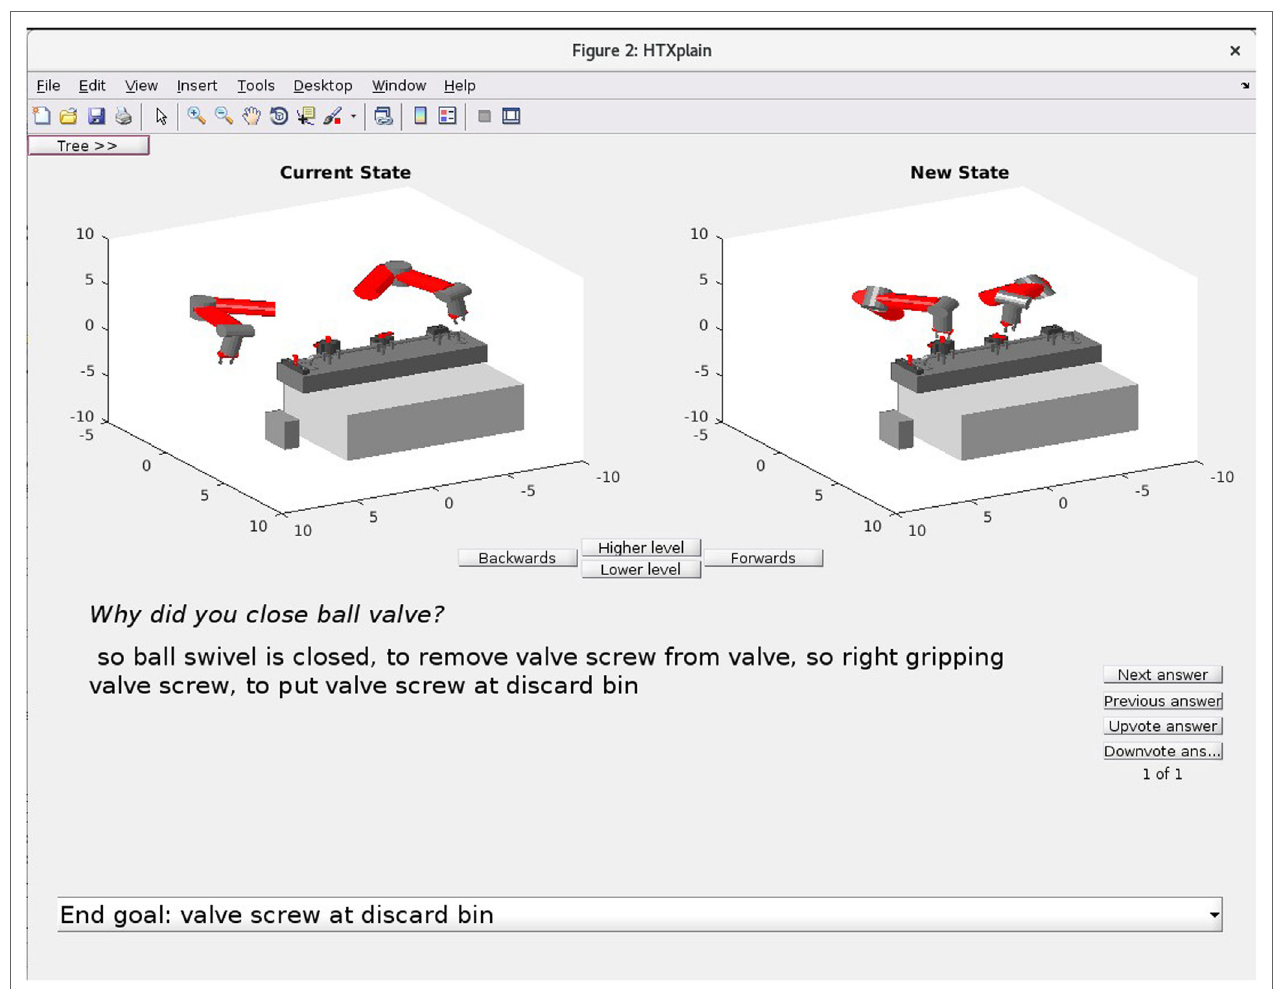
FigUre 2 | Because of its use of cause–effect knowledge and abductive inference methods that are arguably models of human knowledge and reasoning, CERIL can generate simple intuitive justifications of its actions to a person who is observing a humanoid robot at work. While the English is a bit stilted, in the example shown here CERIL is responding to a question as to why it closed a ball valve by describing its reasons (causative factors based on its